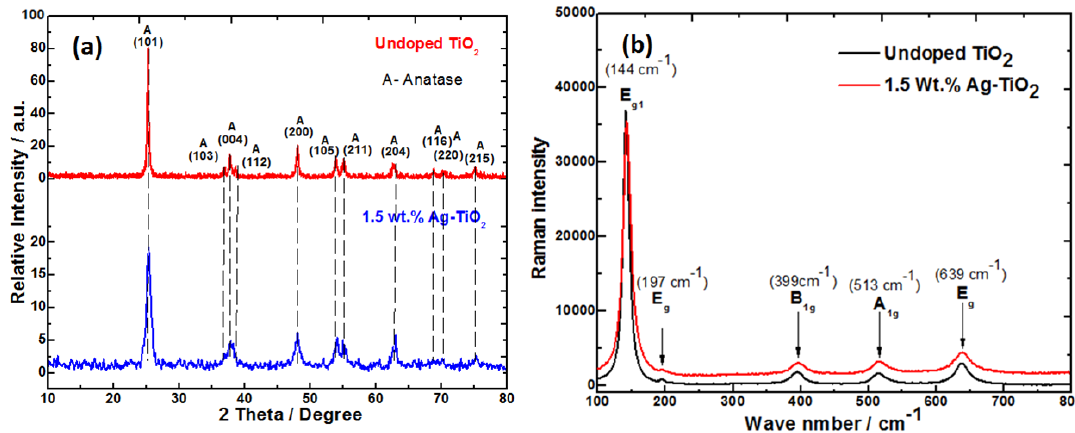
Figure 2. ( a ) Powder X-ray diffraction (XRD) and ( b ) Raman spectra of TiO 2 and Ag-TiO 2 .